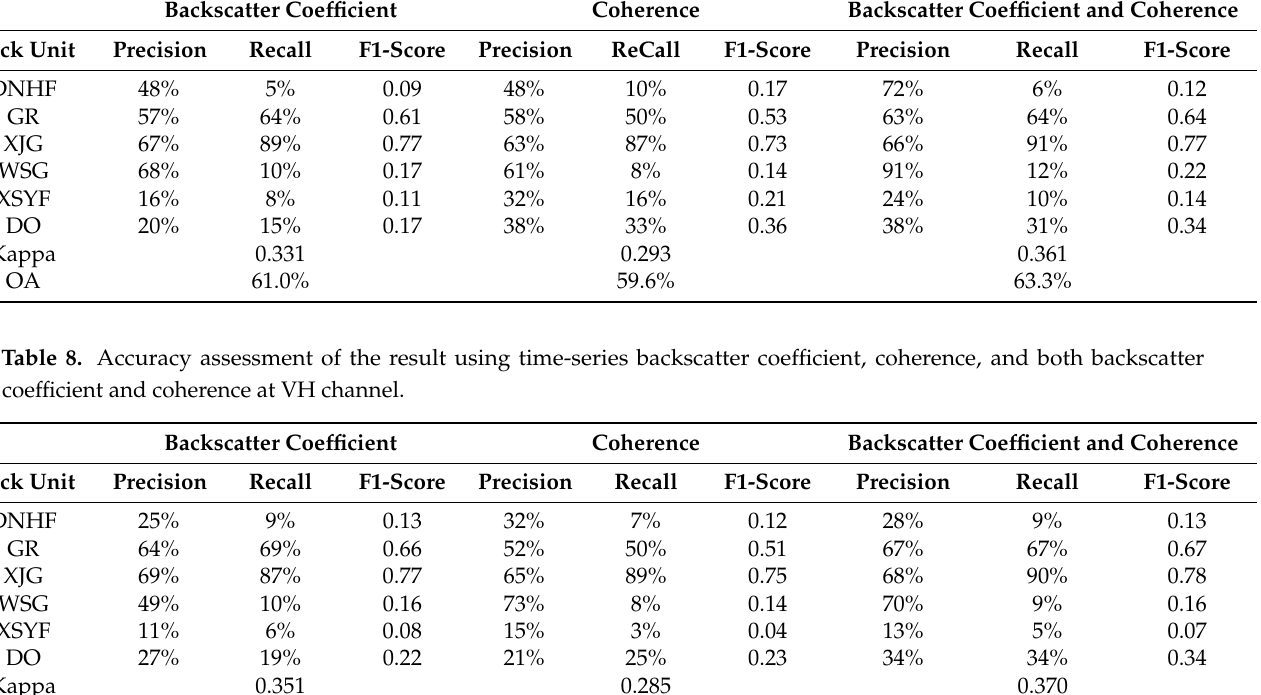
Table 7. Accuracy assessment of the result using time-series backscatter coefficient, coherence, and both backscatter coefficient and coherence at VV channel.